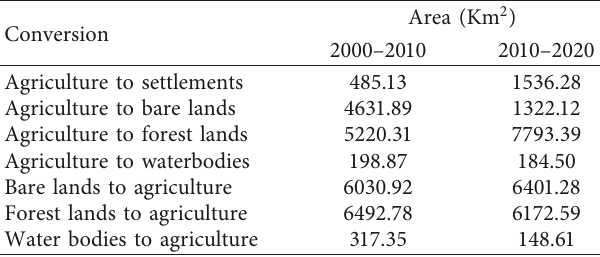
Table 5: Agricultural land cover conversion statistics of Sri